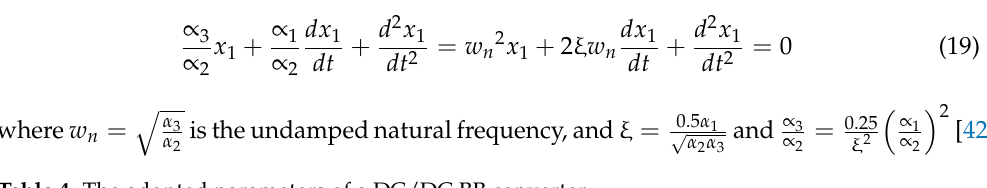
Table 4. The adopted parameters of a DC/DC BB